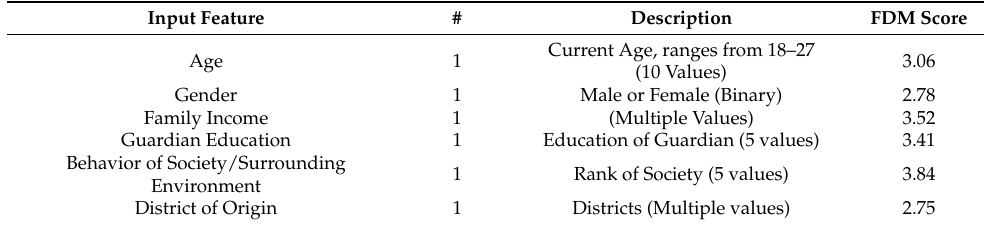
Table 1. Student performance factors and FDM